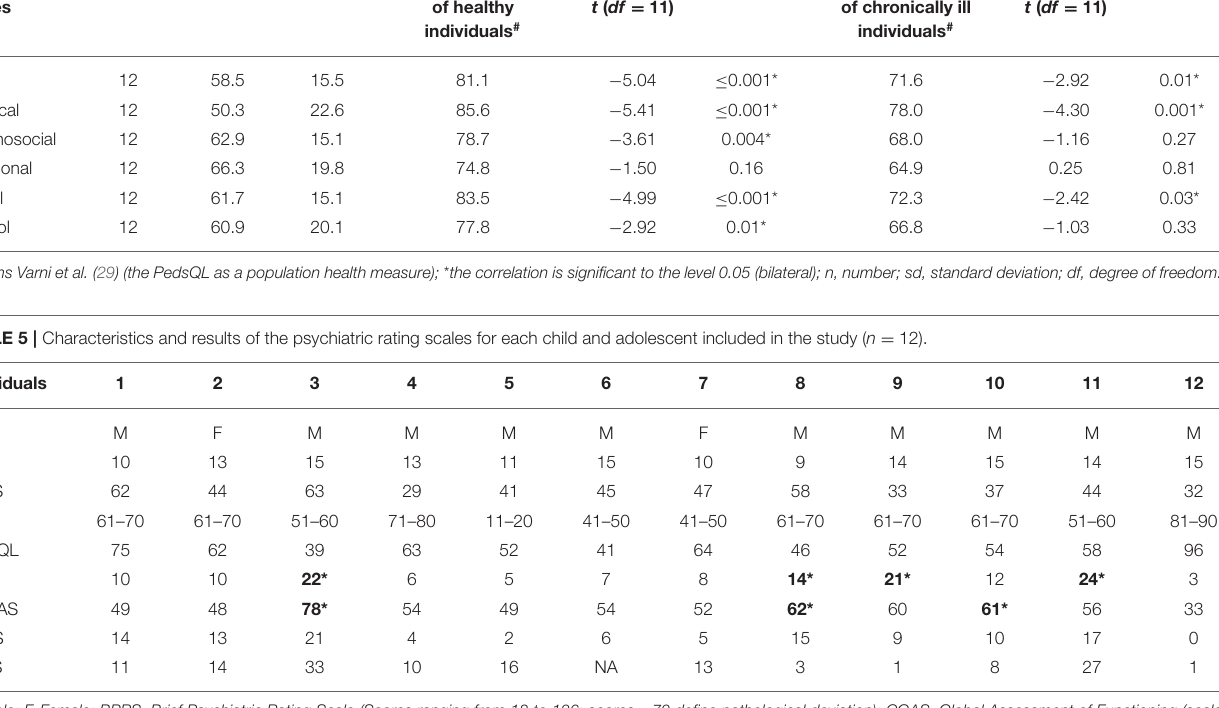
p Mean in a population p Student’s Student’s t ( df = 11) t ( df = 11) of healthy of chronically ill individuals # individuals #